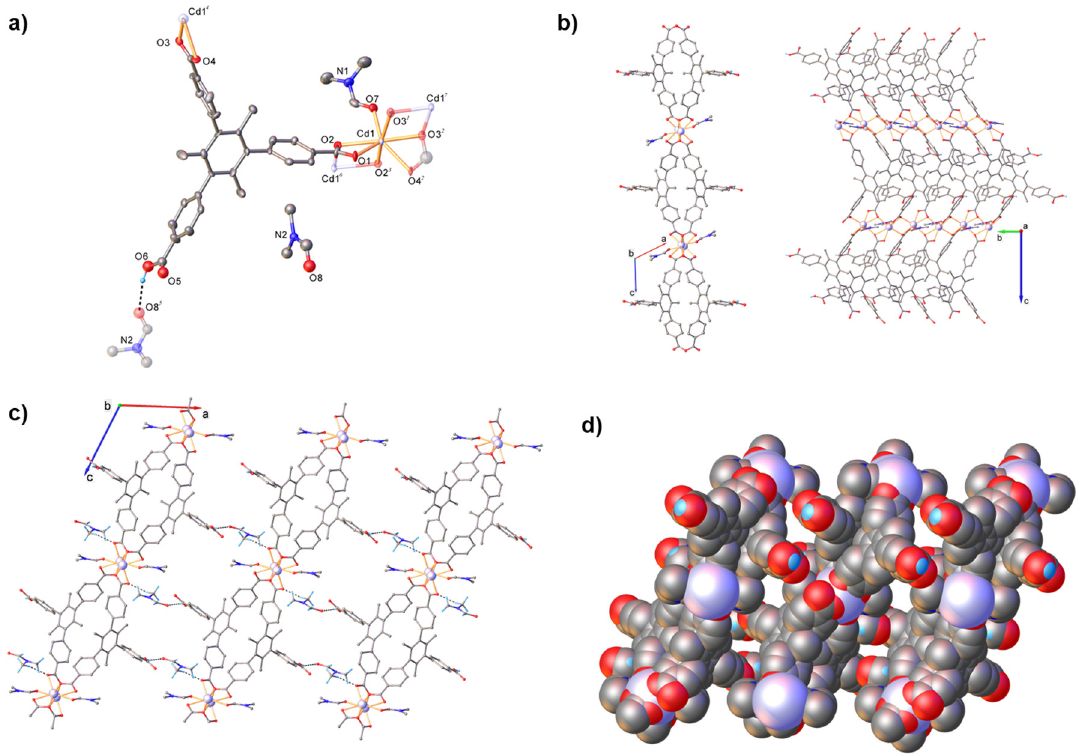
Figure 3. Crystal structure of compound 3 . ( a ) View of the asymmetric unit with thermal ellipsoids at 50% level and selected atom labeling showing the coordination of the Cd atoms. Symmetry-generated atoms are shown with faded colors; ( b ) View of the 2D coordination polymer; ( c ) Crystal packing viewed along the b axis; ( d ) Space-filling model. Non-relevant H-atoms are not shown. Symmetry codes: 1 ) 3/2 − x , ½ + y , ½ − z ; 2) x , 3 − y ,1/2 + z ; 3) 3/2 − x , 5/2 − y , 1 − z ; 4 ) x , 3 − y , z − 1/2; 5 ) 1 – x , 1 + y , ½ + z ; 6 ) 3/2 − x , 5/2 − y , 1 − z; 7 ) 3/2 − x , 7/2 − y , 1 − z.